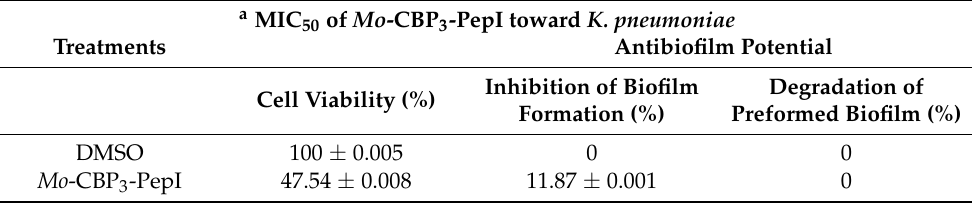
Table 1. Cell viability and antibiofilm potential of Mo -CBP3-PepI against K. pneumoniae . a MIC 50 of Mo -CBP 3 -PepI toward K.